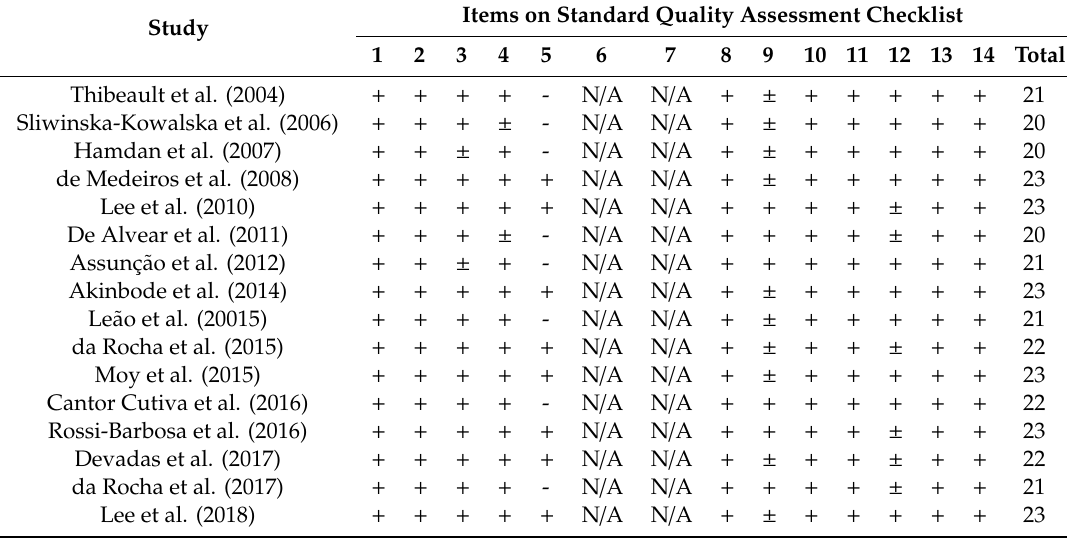
Table 1. Results of standard quality assessment criteria for evaluating primary research papers from a variety of